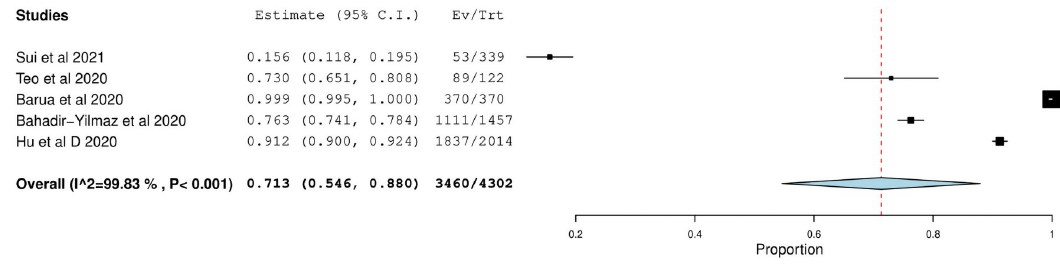
Fig 6. Forest plot of overall pooled prevalence of fear.